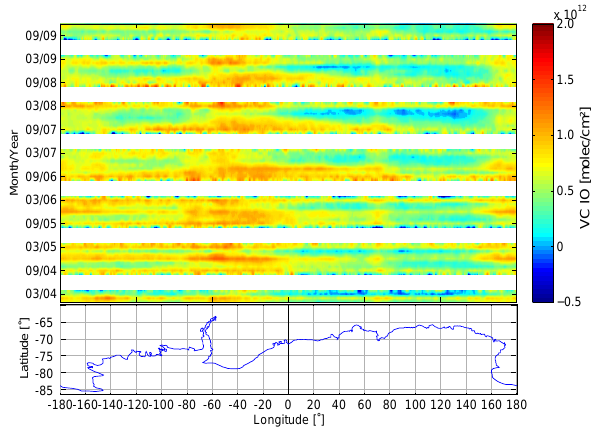
Fig. 6. Contour plot showing the variation of IO average columns with longitude (horizontal axis) and time (vertical axis). IO amounts are averaged within the latitude band 80 ◦ S to 60 ◦ S. The map below shows the Antarctic coast line.